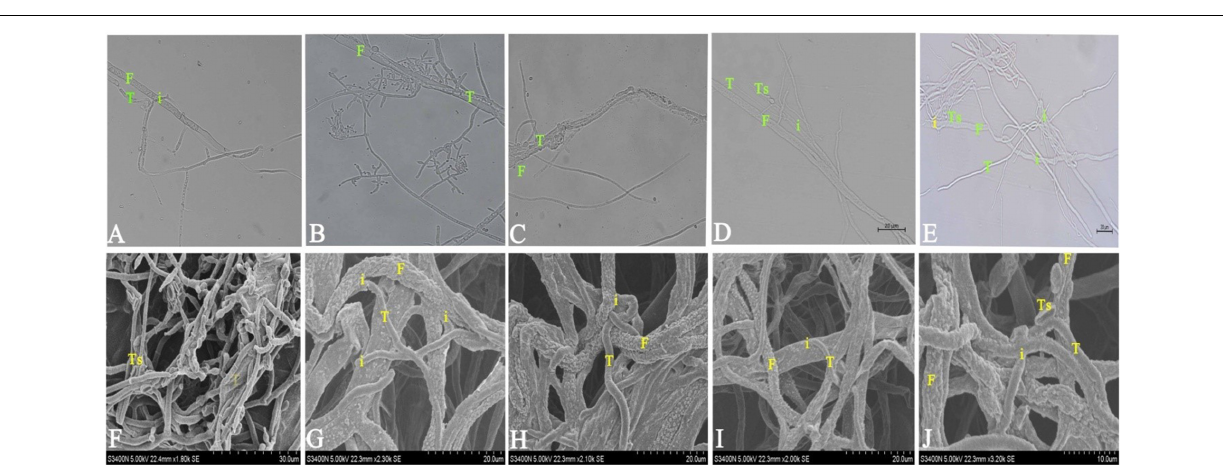
FIGURE 2 | Effect of different NaCl concentrations on colony growth and inhibition between T. longibrachiatum (TG1) and F. pseudograminearum (Fg) at 4 days after inoculation using dual plate assay (0–150 mM of NaCl concentrations). (A) front colony, and (B) reverse colony.